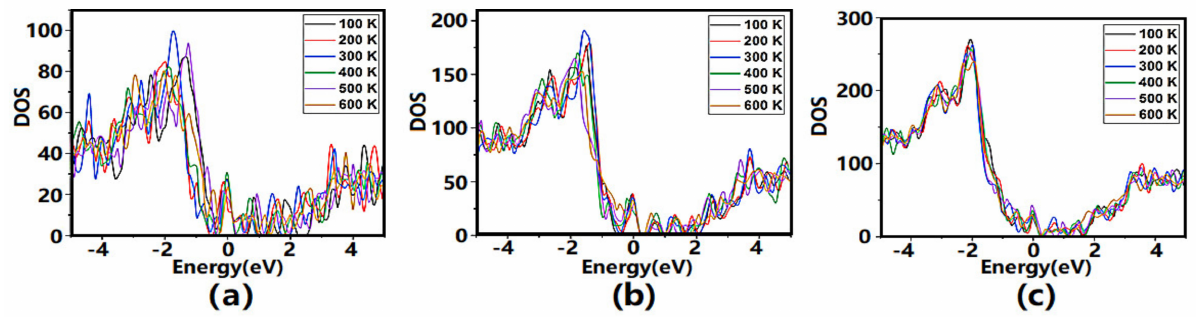
Figure 2. Total density of states (TDOS) of 1 nm ( a ), 2 nm ( b ), and 3 nm ( c ) ITO models near the Fermi level ( − 5 to 5 eV) at temperatures ranging from 100 to 600